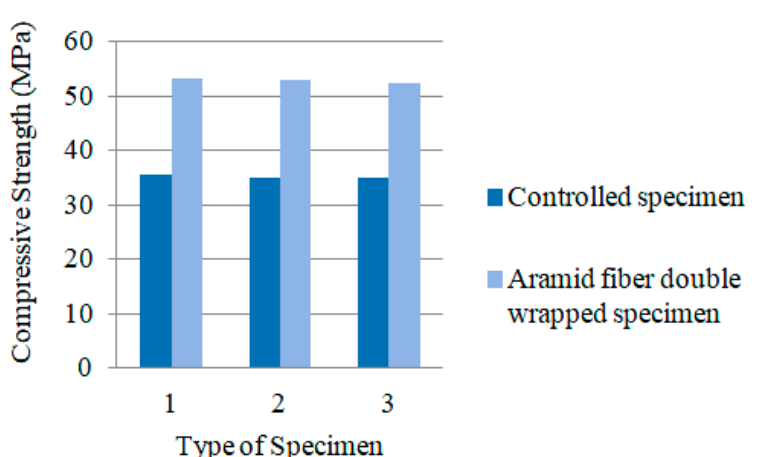
Figure 8. Weight loss at 200 °C—2 h.